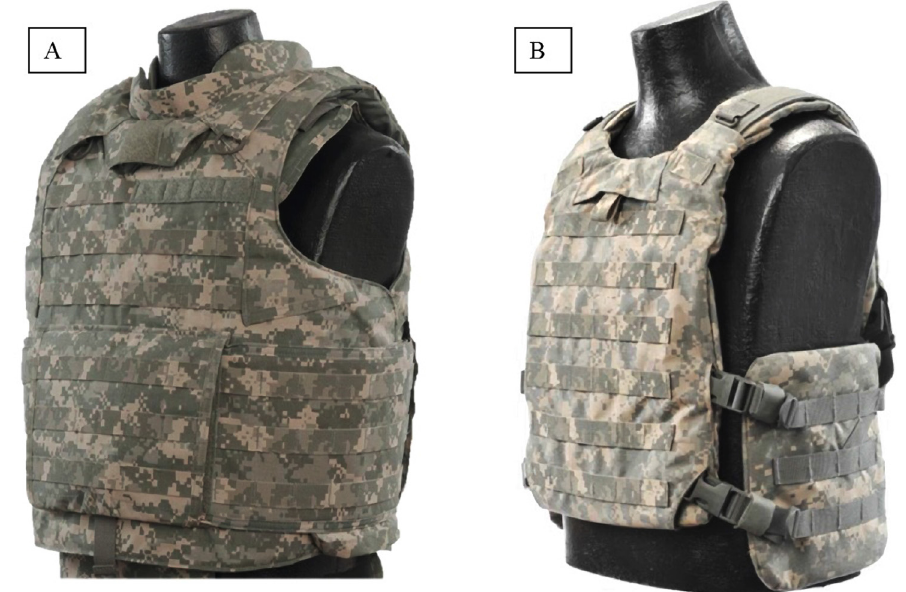
Fig 2. Soft armor vest and plate carrier used in configurations BA-1 through BA-7. Foot note: A — soft armor vest (IOTV) configurations (BA-1, BA-5, BA-6, and BA-7); B — plate carrier configurations (BA-2, BA-3,